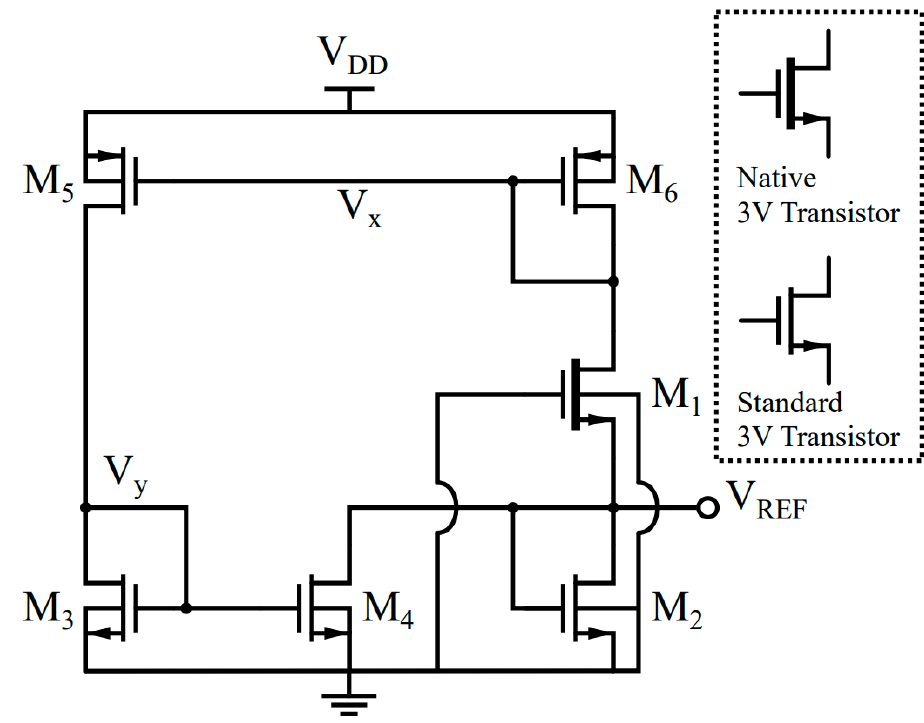
Figure 2. Schematic of the proposed voltage reference circuit.